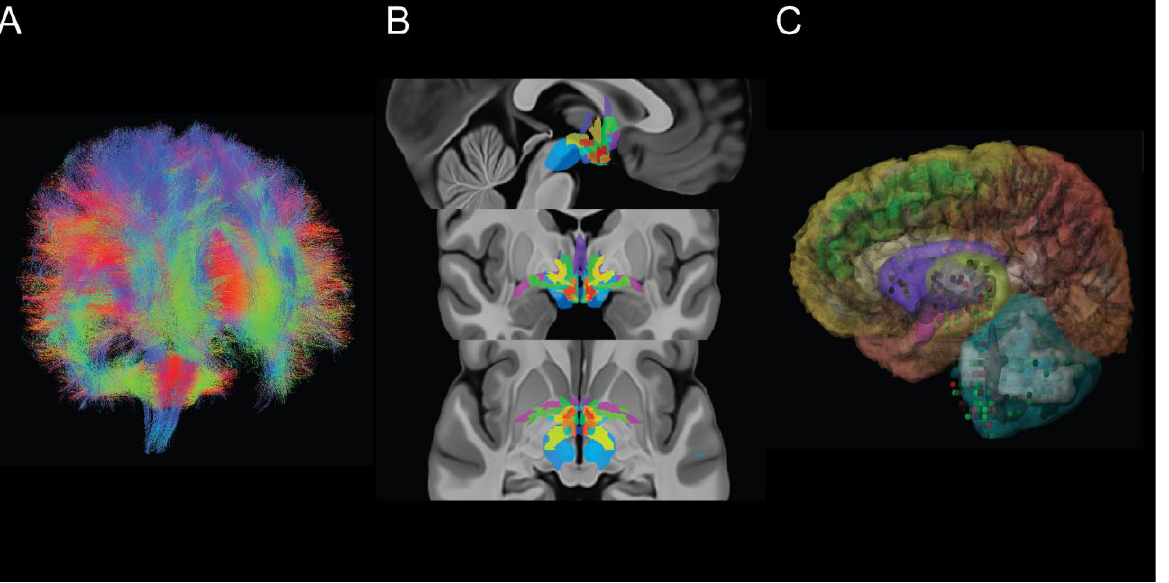
Figure 1. Examples of reference brain atlases in MNI space. ( A ) Connectome tractogram compris- ing ~12 million streamlines derived from normative Human Connectome Project dMRI data [43]. ( B ) High-resolution atlas consisting of manually segmented hypothalamic and extrahypothalamic nuclei [18]. ( C ) Allen Human Brain Atlas, showing gene expression probes for O-6methylguanine-DNA methyltransferse (MGMT) for one of the patients [27]. Table 1. Example analysis tools and spatial reference maps available in MNI space.